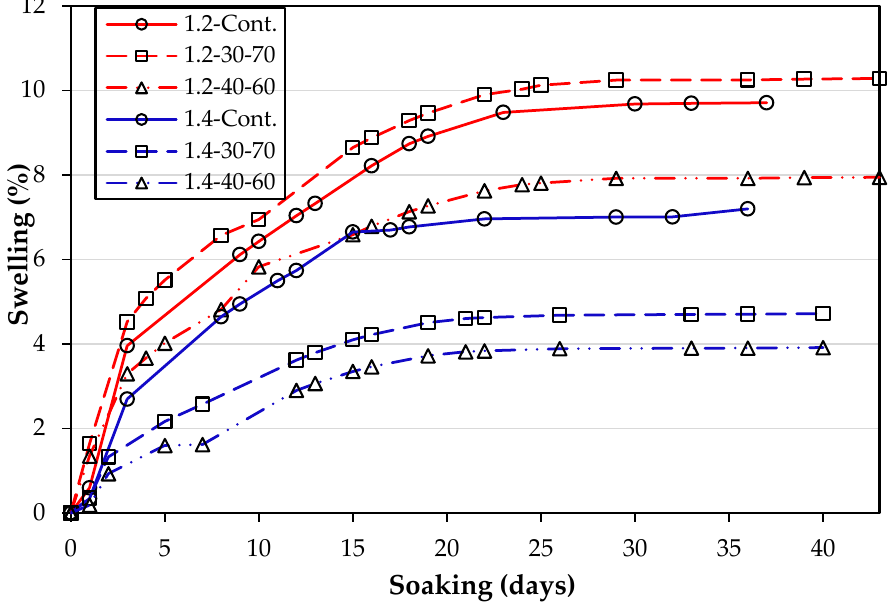
Figure 3. Linear expansion plots for Kaolinite clay specimens dosed with 6 wt.% Gypsum, at varying OMCs.